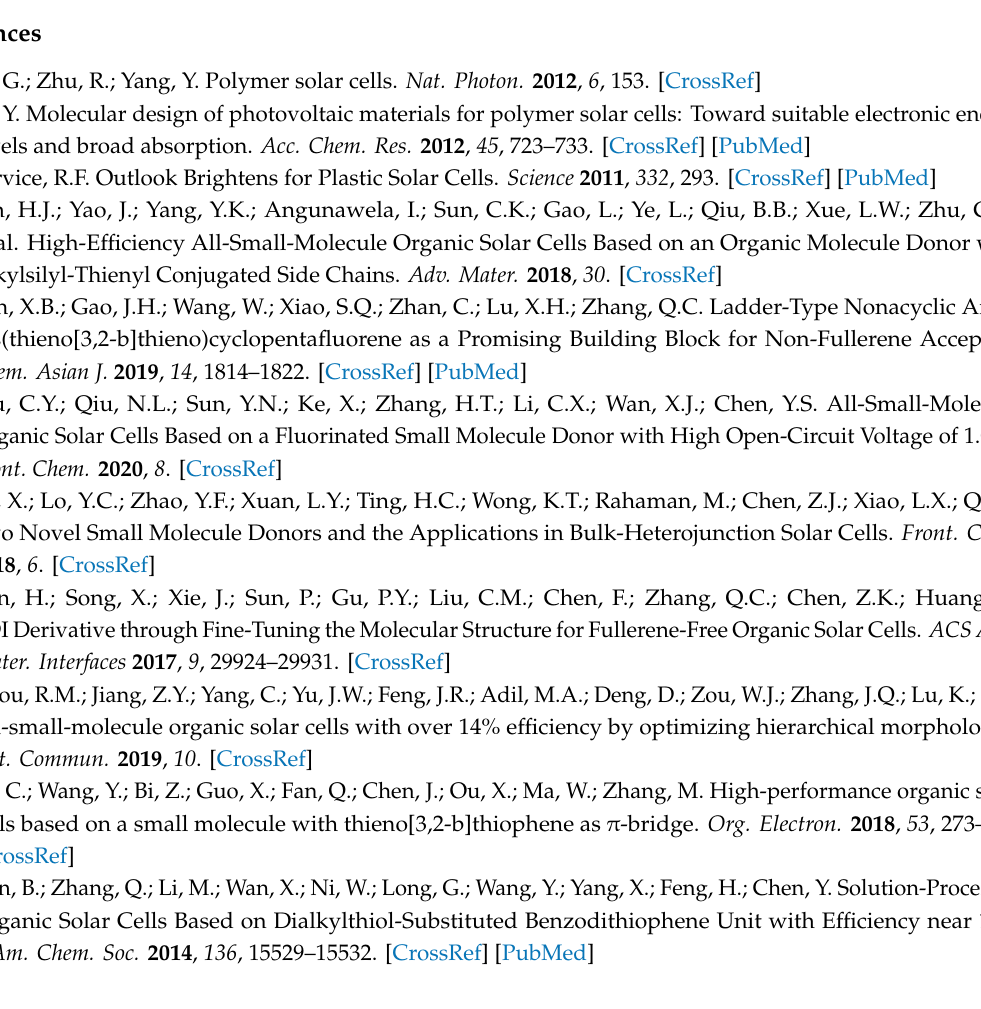
Figure S1: Thermal stability of SM-OPV devices. All the devices were subjected to thermal stress at 80 ◦ C for 1000 h. Figure S2: 2D images of GIXRD as prepared (a) Binary, (b) Ternary-F, and (c) Ternary-CN films and light soaked (d) Binary, (e) Ternary-F, and (f) Ternary-CN films. Figure S3: Plots of log ( J SC ) versus log ( I ) for all the devices. Table S1: In-plain π - π stack peak information of Binary, Ternary-F, and Ternary-CN films before and after light soaking. Table S2: Out-of-plain lamellar stack peak information of Binary, Ternary-F, and Ternary-CN films before and after light soaking. Table S3: The S values of all devices before and after light